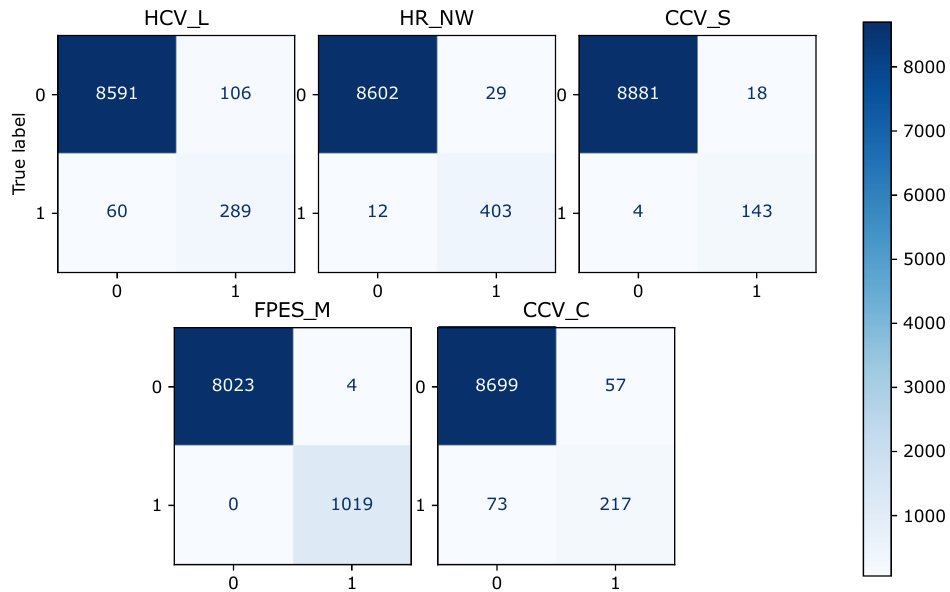
Figure 3. Diagram of the confusion matrix of different fault classes for the logistic regression model, for five fault types. The vertical axes represent the actual labels, and the horizontal axes represent the predicted labels for the corresponding fault classes. The total number of correctly predicted samples is the sum of all actual samples labeled as true and classified as true, and the actual samples labeled as false and classified as false.